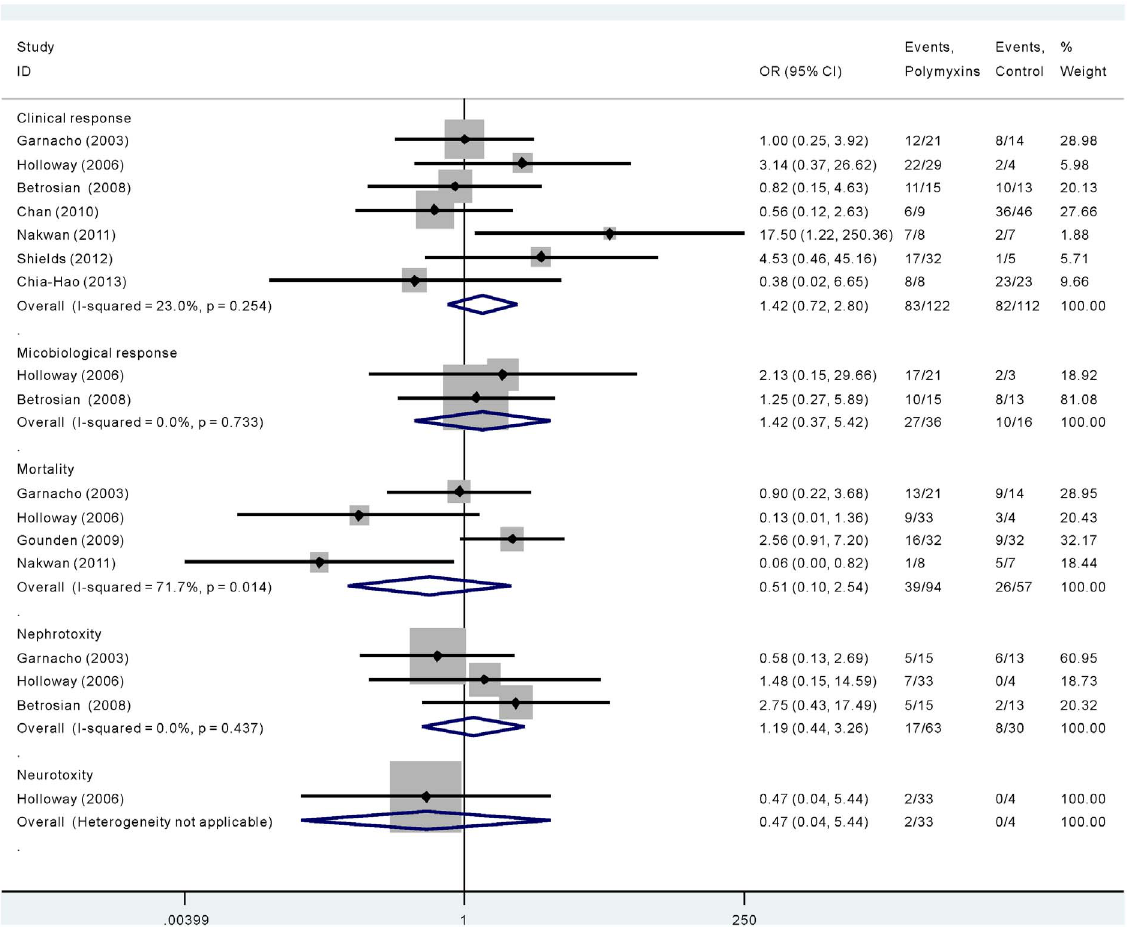
Figure 2. The efficacy and safety of polymyxins compared with other antibiotics in Acinectobacterbaumannii infection.